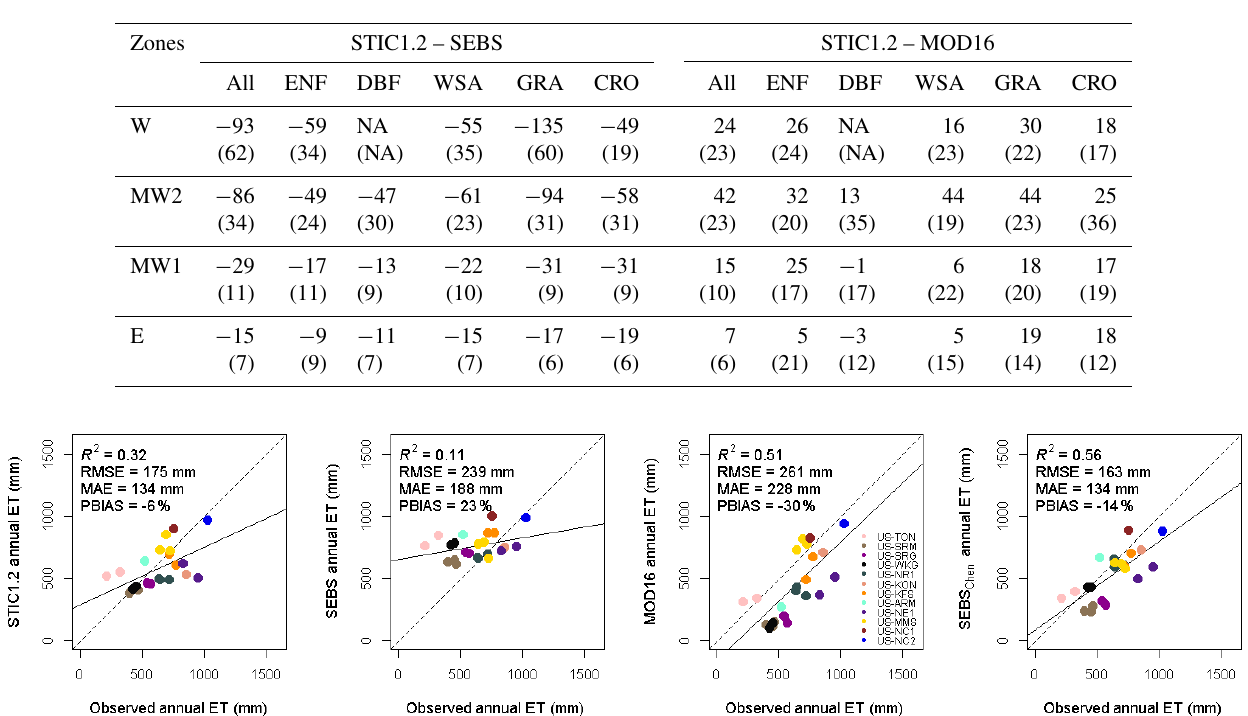
Table 6. Mean percent difference in annual ET (standard deviation in parentheses) between STIC1.2 vs. SEBS and MOD16 within the bounding box of the four study zones considering all pixels and five vegetation types based on MCD12Q1 products (Friedl et al., 2010). NA = not available.